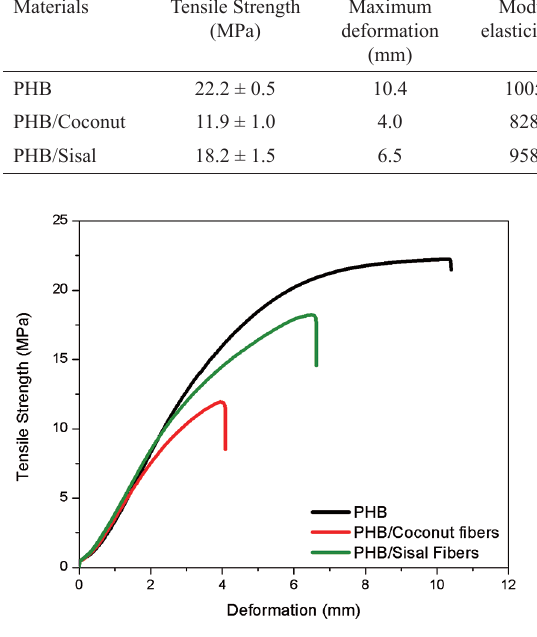
Figure 12: Representative mean curves from tensile test of PHB composites and PHB without fibers tested at room temperature